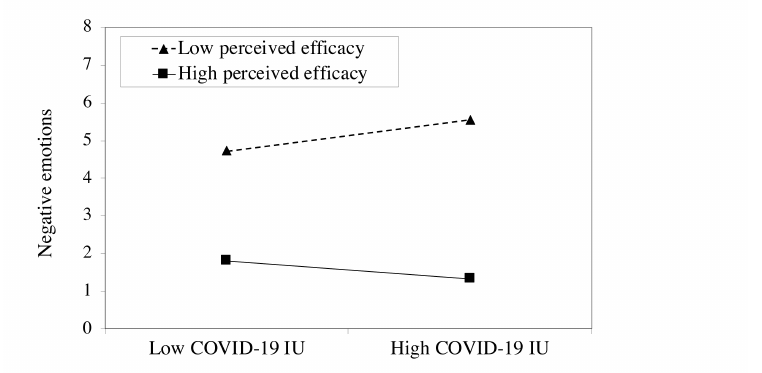
Figure 2. Perceived efficacy moderates the relationship between COVID-19 IU and negative